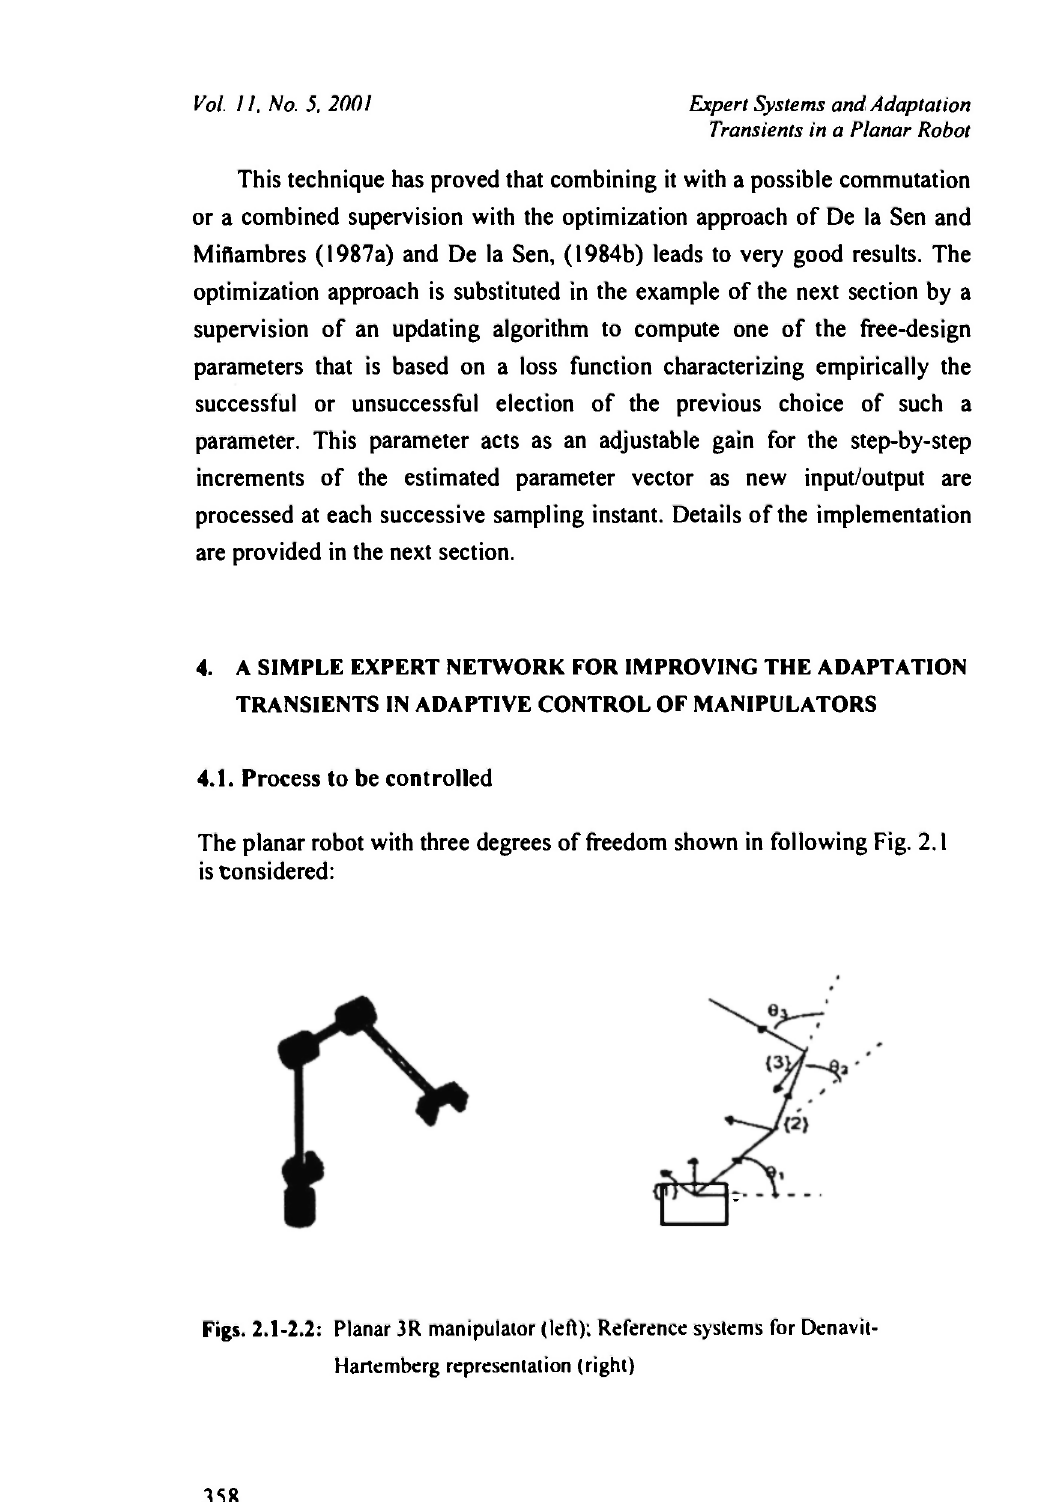
Figs. 2.1-2.2: Planar 3R manipulator (left); Reference systems for Denavit- Hartemberg representation